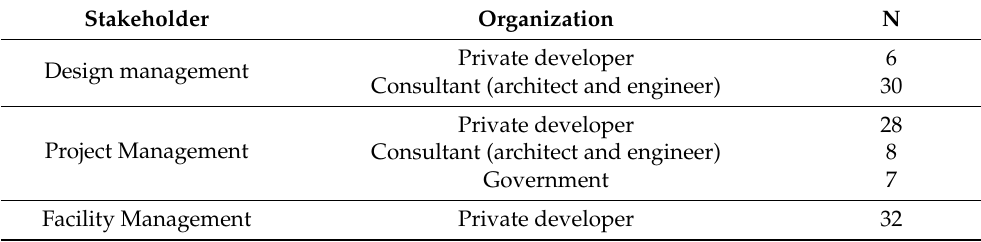
Table 2. Organization of respondents.